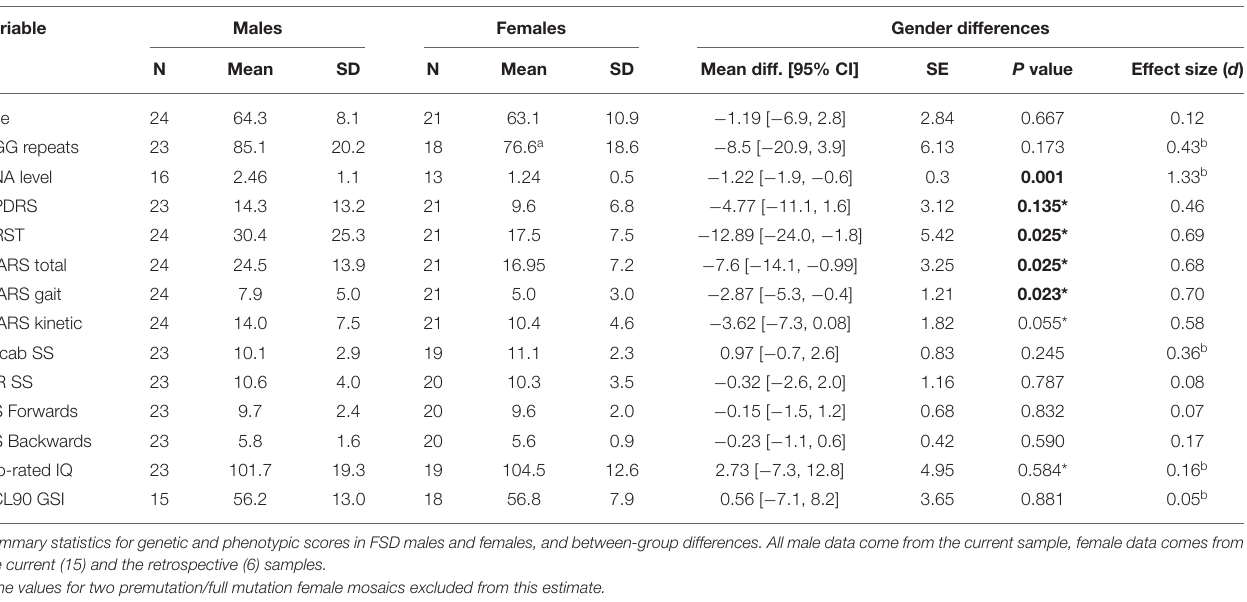
TABLE 2 | Cross sectional study.